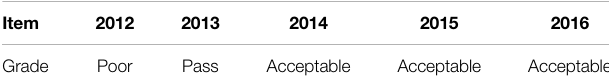
TABLE 6 | Assessment result of comprehensive development level of reclaimed water.